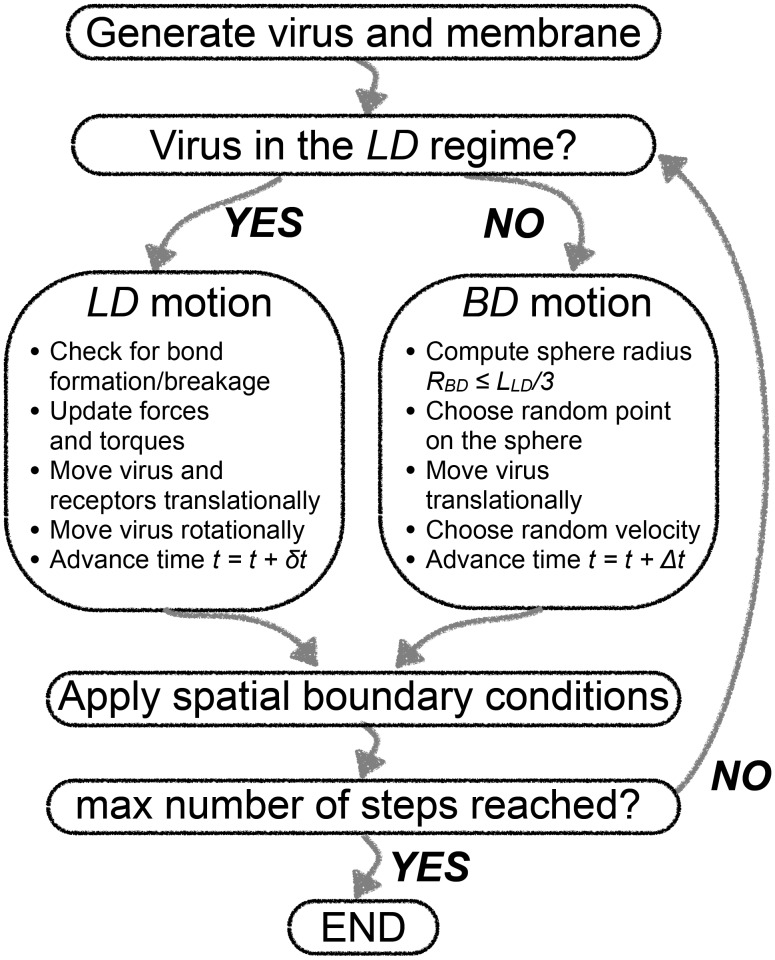
Algorithm flowchart.At each time-step, the virus' position within the computational box is determined relative to the receptor-containing membrane. If a virus particle is within the Langevin Dynamics (LD) region close to the membrane (below the LD region threshold LLD), it can stochastically bind to or unbind from one or several receptors. After computing the bond forces and torques, the translational and rotational position of the virus and the translational positions of the receptors are updated by a Langevin dynamics algorithm, and time is increased by a fixed time-step δt. If the virus is located in solution above a certain threshold (i.e., in the Brownian Dynamics (BD) regime), no binding is possible and the virus' translational position is updated in a diffusive Brownian-motion manner. Time is increased by an adaptive, distance-dependent increment Δt. After applying the spatial boundary conditions – periodic in x and y directions within the membrane plane and a reflection in the z direction orthogonal to the membrane – the cycle is repeated until the virus either leaves the computational box or time has reached a pre-defined maximum (see Table 1).